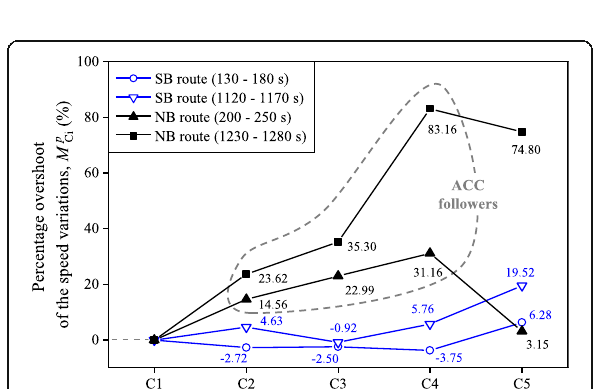
Fig. 4 The percentage overshoots of speed variations in the